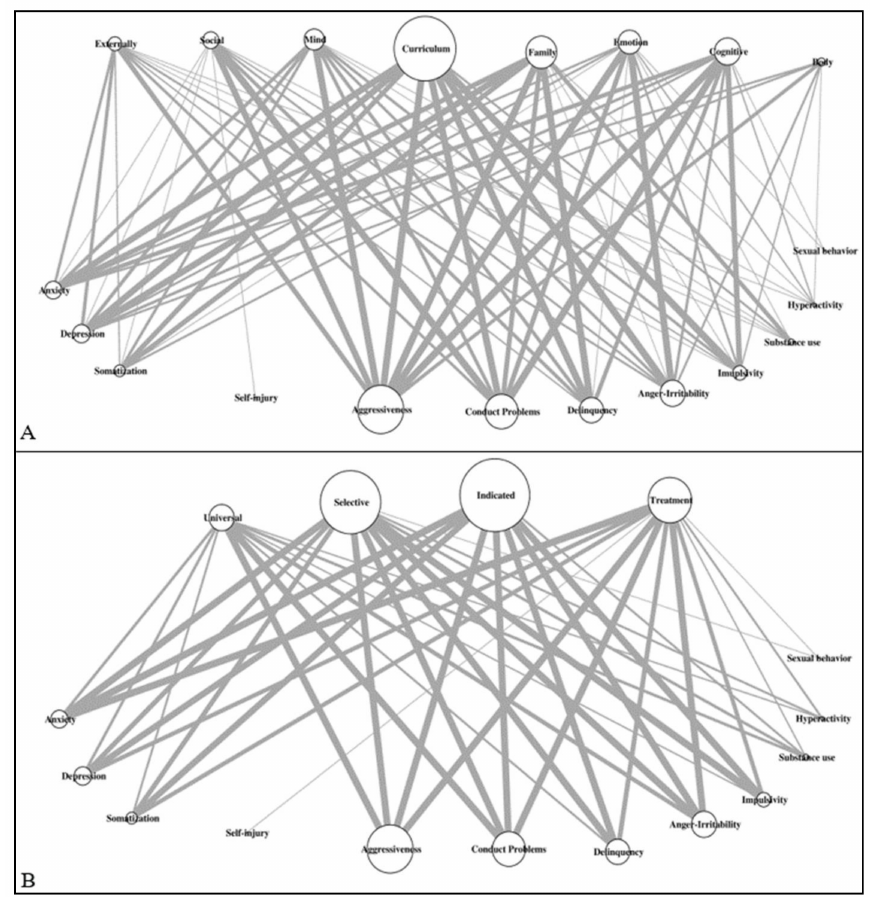
Figure 2. Illustration of the network between symptoms and type of intervention ( A ) or interven- tion stage; ( B ) Legend: upper part: type of intervention ( A ) or intervention stage ( B ); lower part: psychopathological symptoms. The size of the vertex is relative to the number of studies. The edge widths are relative to the number of studies (up to 10, for illustration